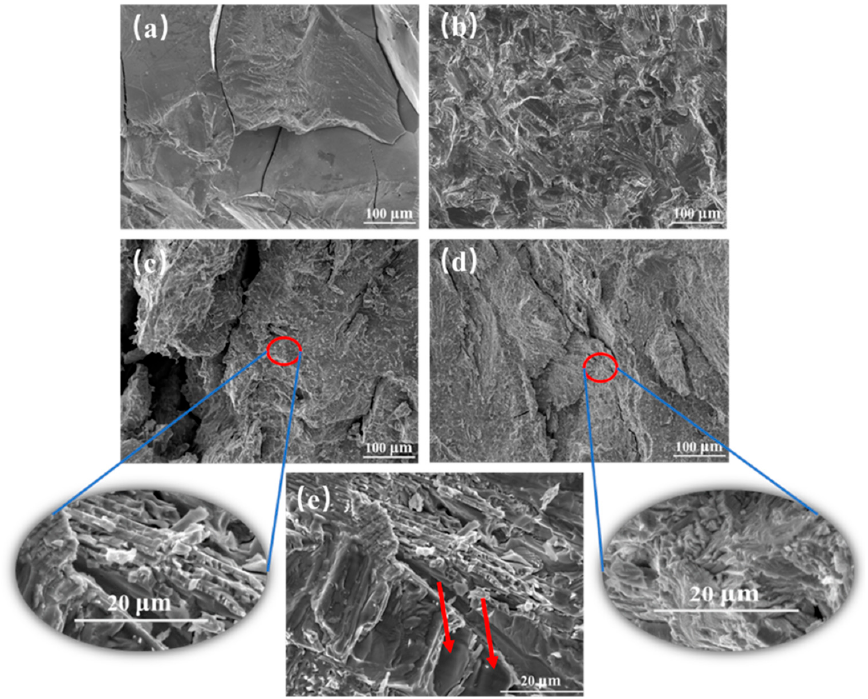
Figure 8. SEM fractographs of Ni 48 Mn 39 Sn 13 − x Tb x alloys ( a ) x = 0; ( b ) x = 0.5; ( c ) x = 1; ( d ) x = 2; ( e ) x = 5.